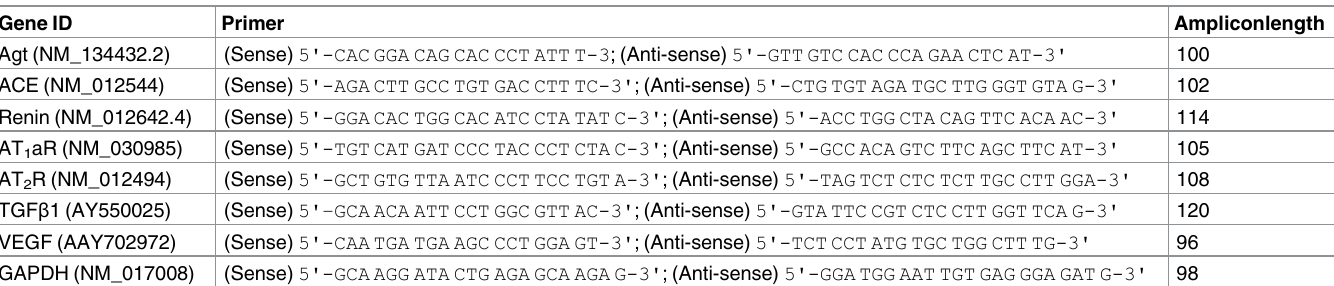
Table 2. Primers used for qPCR gene